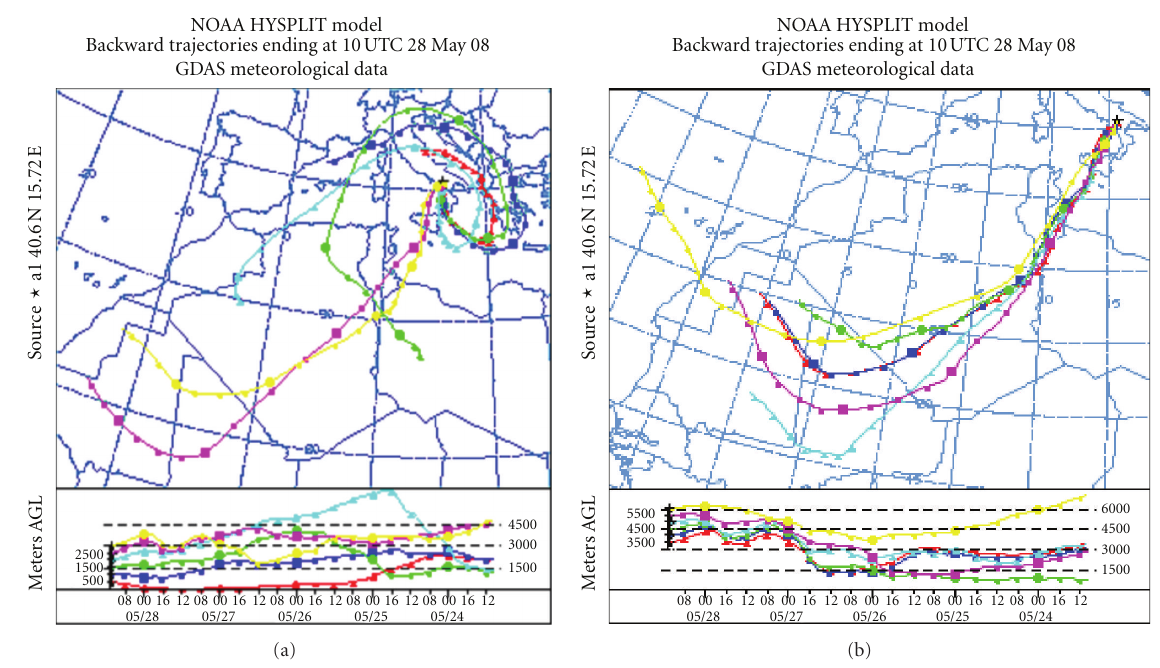
Figure 5: Low-level and high-level back-trajectories for May 28,